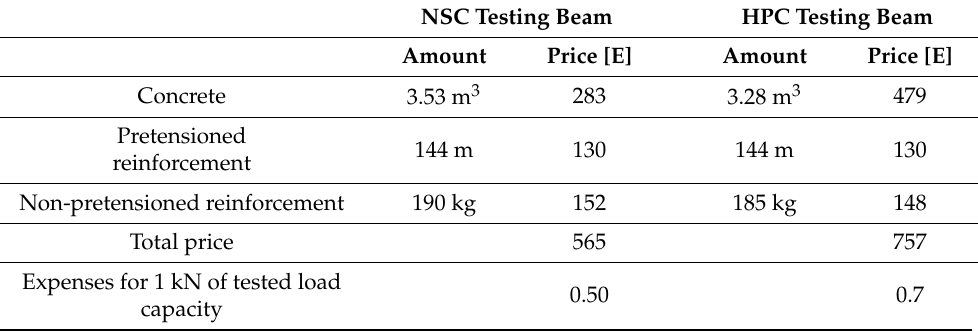
Table 7. Tentative expenses of testing beams.